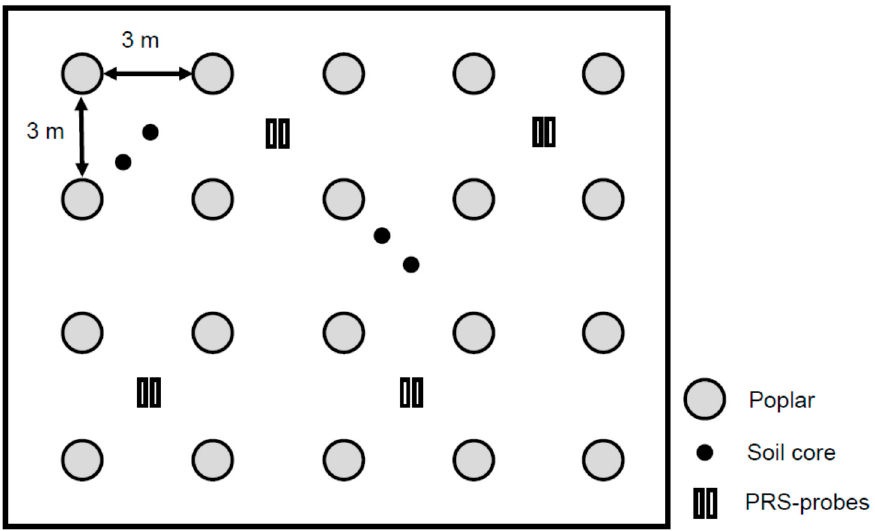
Figure A1. Schematic representation of the sampling design used for the soil core extractions and for the evaluation of soil nutrient supply rate with the PRS-probes. The experimental plot shown represents the 1111 trees/ha (3 × 3 m spacing) treatment.